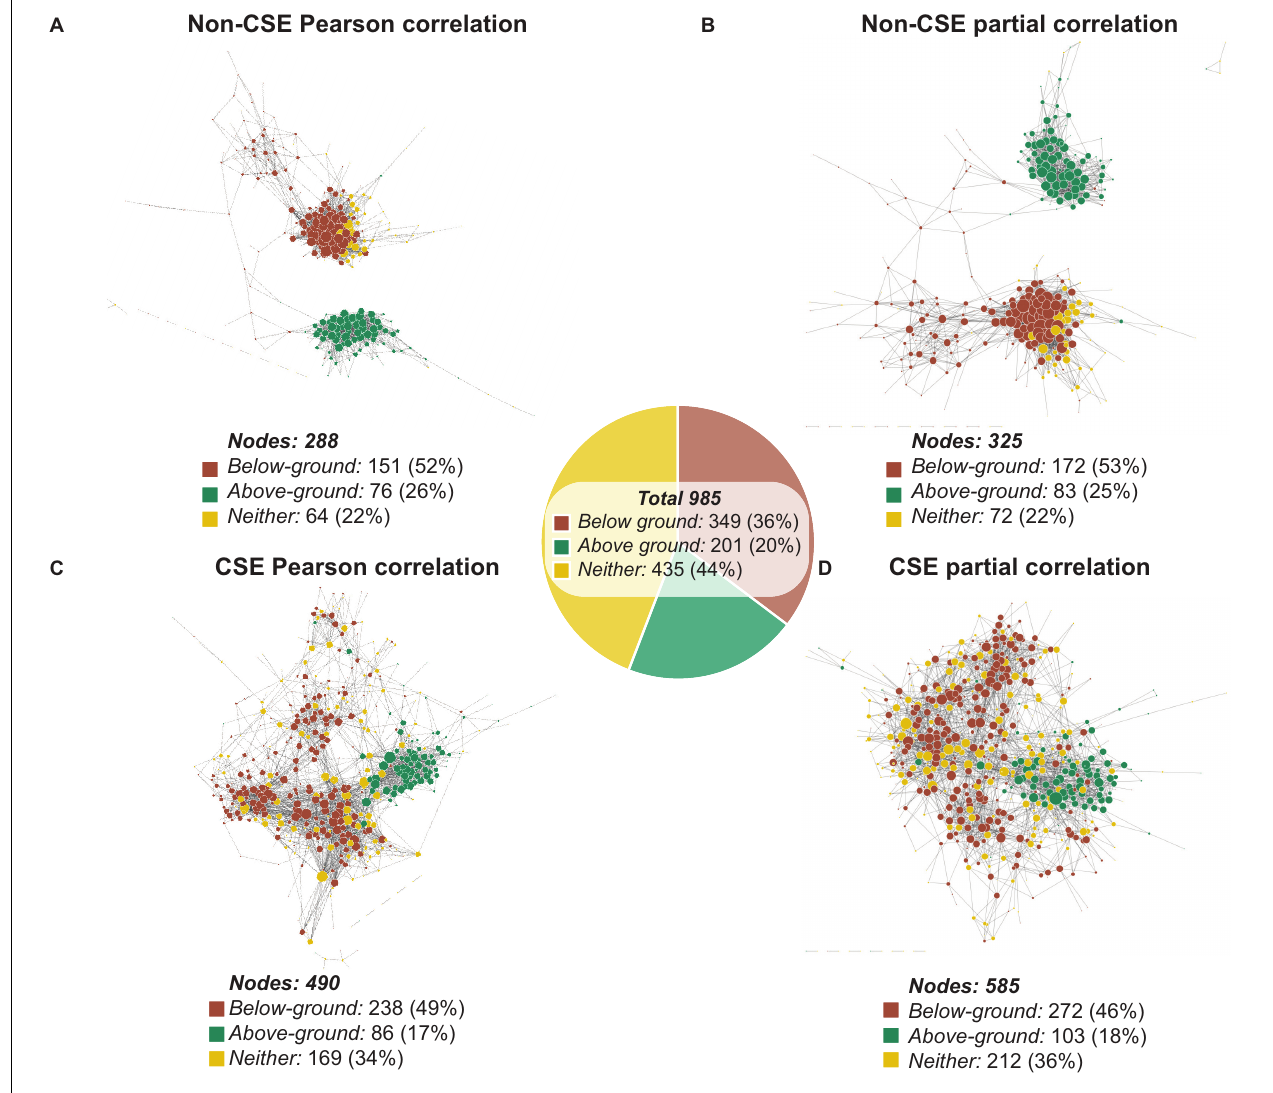
FIGURE 2 | Visualization of the mitochondrial network using four different pre-processing and correlation approaches. A manually curated mitochondrial gene list was cross-referenced with the AtGenExpress Expression Atlas spanning different tissues, developmental stages, and stresses (Schmid et al., 2005; Kilian et al., 2007; Goda et al., 2008). This data was either subject to CSE or left unprocessed, prior to correlation analysis using either Pearson correlation or partial correlation. Each of the four resulting networks was visualized using Cytoscape. For each network, only nodes with at least one edge to another node were included. Each node (gene) was colored based on their classification as either below-ground dominant (brown), above-ground dominant (green) or dominance in neither tissue (yellow). The diameter of each node is proportional to the number of edges it has to a neighboring node. (A) Network of non-CSE Pearson correlation. (B) Network of non-CSE partial correlation. (C) Network of CSE Pearson correlation. (D) Network of CSE partial